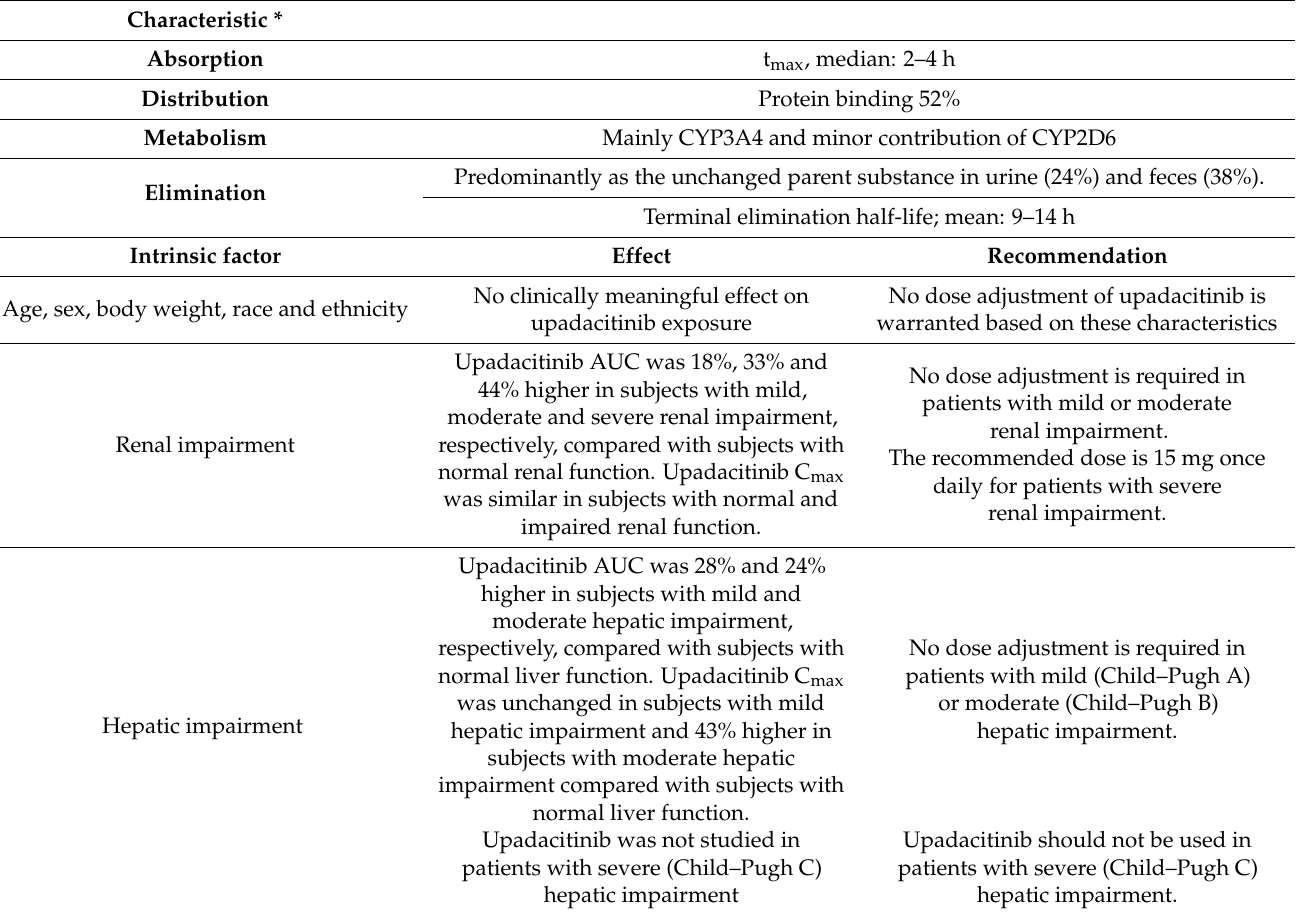
Table 1. Main pharmacokinetic characteristics of extended upadacitinib